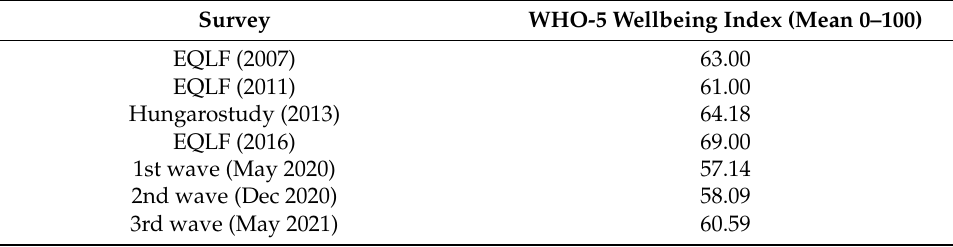
Table 7. Subjective psychological well-being of the Hungarian population in the different surveys.